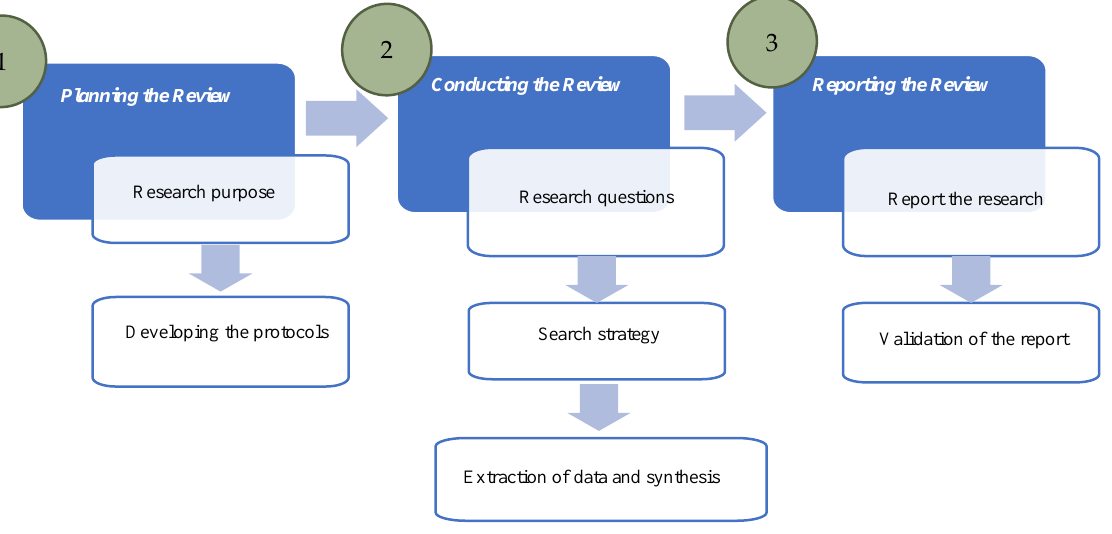
Figure 1. Stages of the SLR.